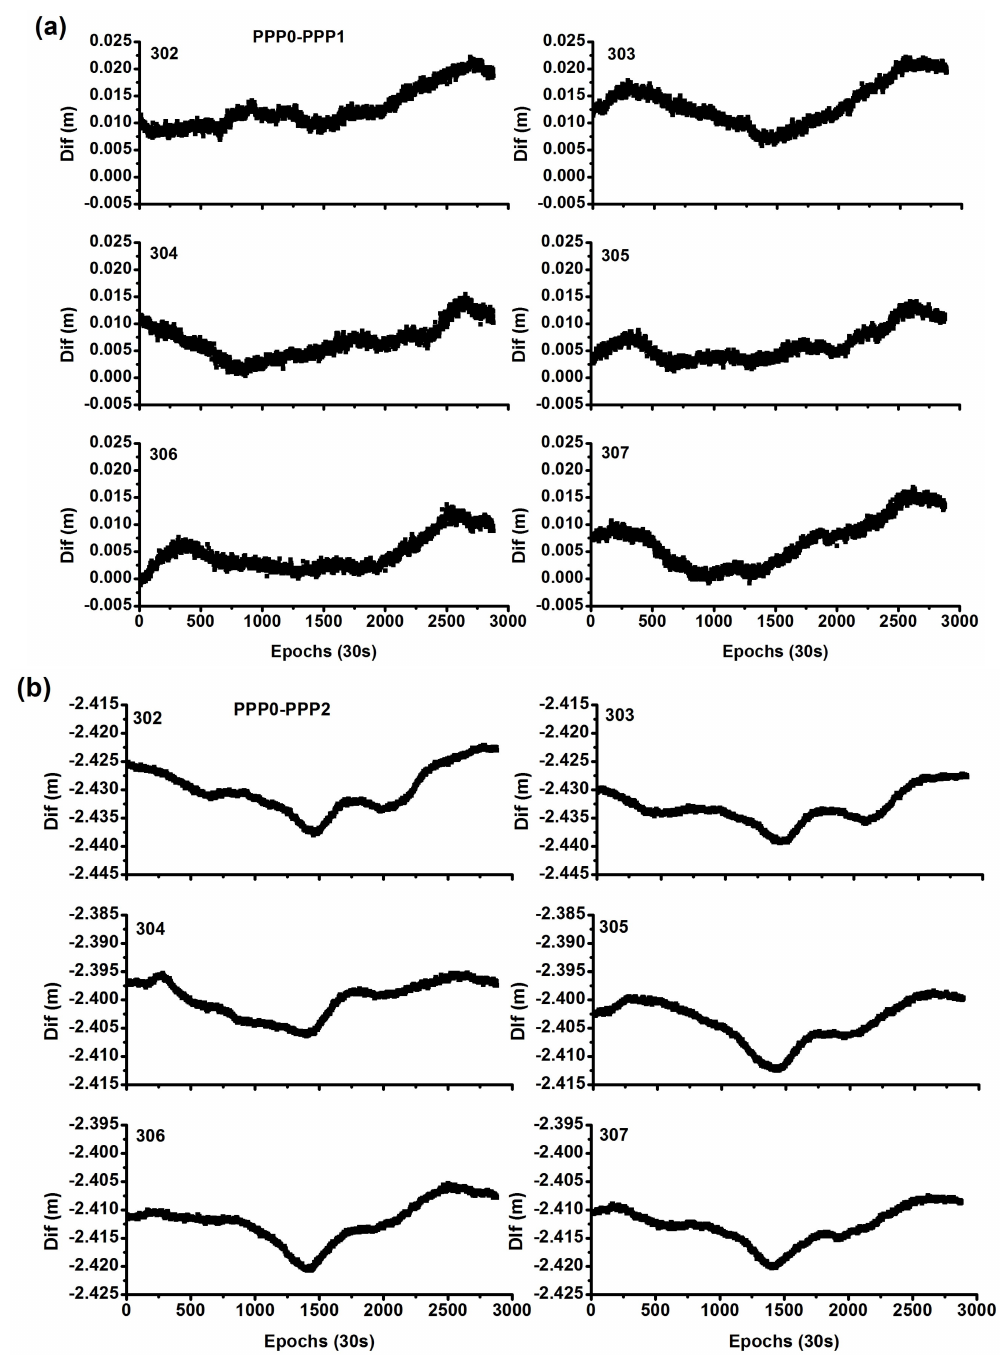
Figure 12. Comparison of system bias between different models by stations CEDU and KAT1 (( a ) represents “PPP0-PPP1”, ( b ) represents